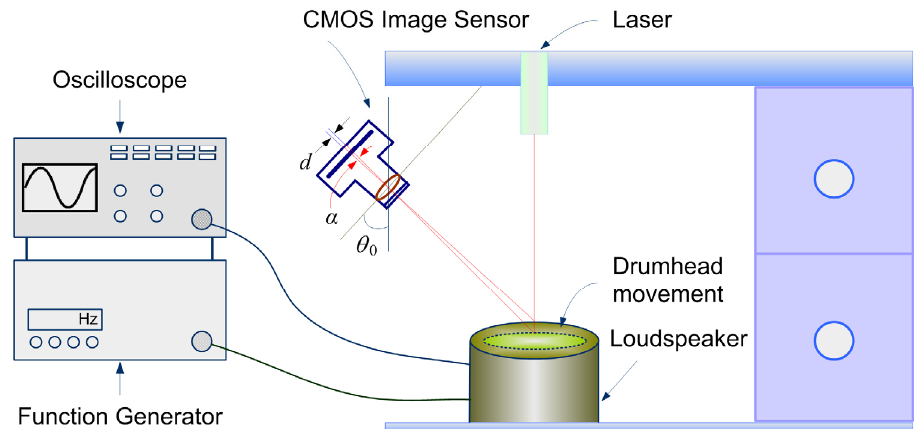
Figure 7. The schematic drawing of the frequency calibration of the APM system.